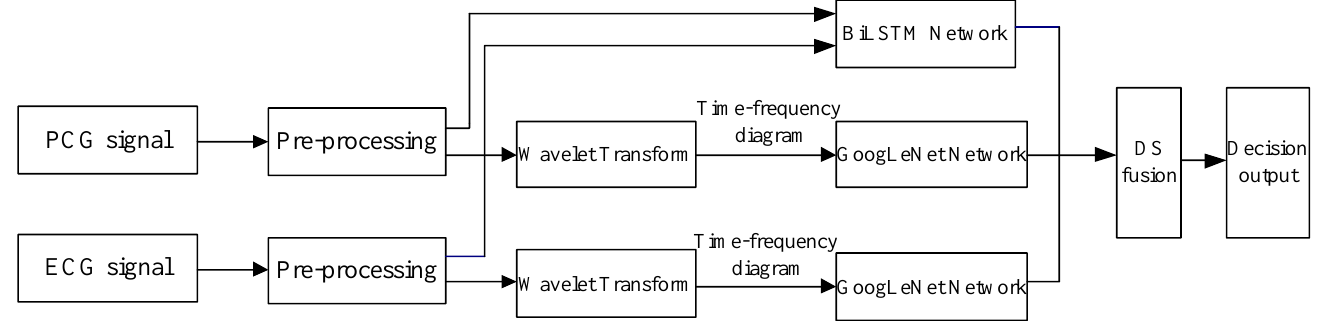
Figure 1. Classification method and implementation process of ECG and PCG signals.